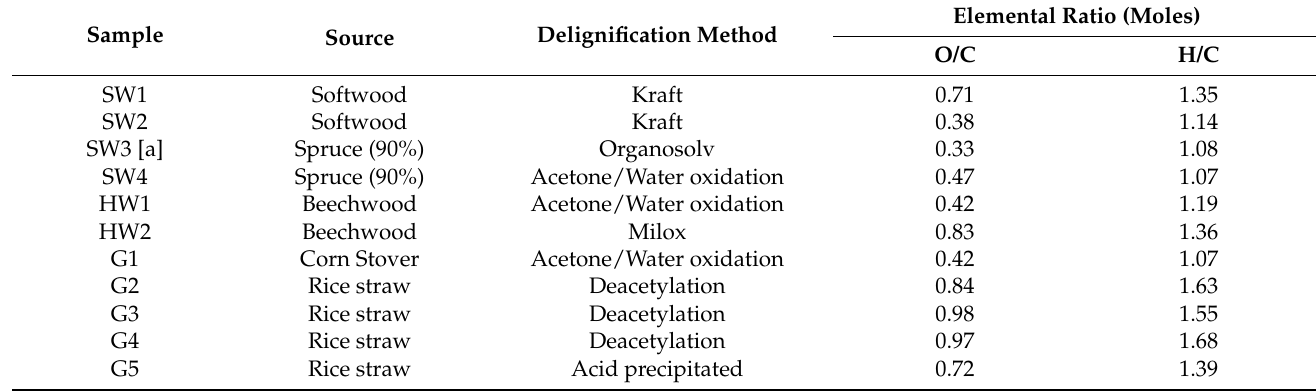
Table 1. Lignin characteristics. Elemental ratio based on mol%.